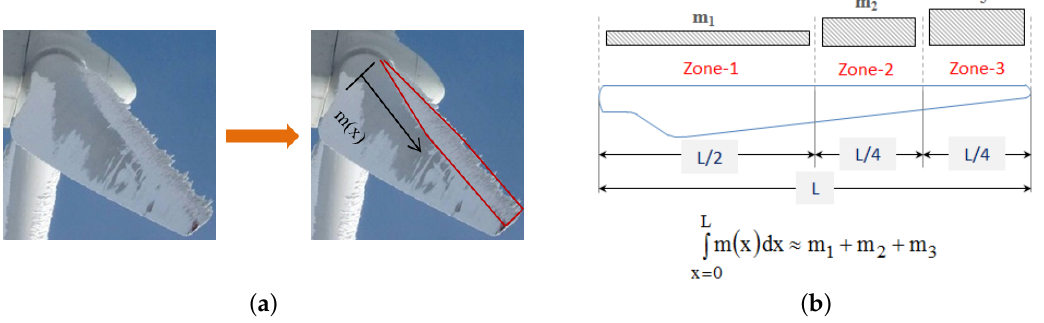
Figure 13. ( a ) A typical ice mass distribution on a wind turbine blade; ( b ) approximation of the continuous ice mass distribution along the blade in terms of three mass